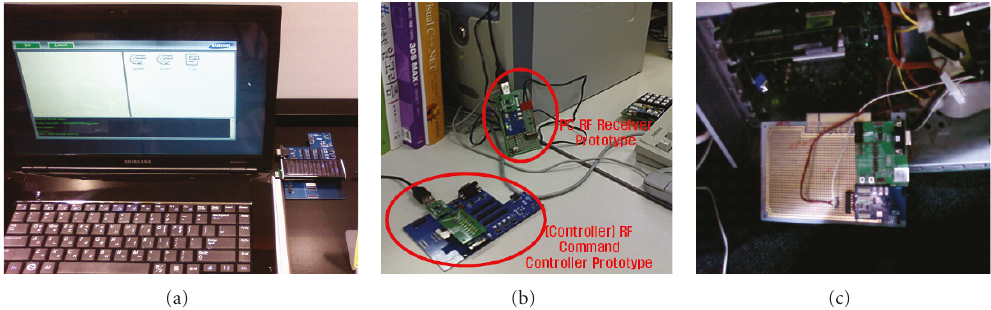
Figure 10: Installed zero-configuration modules for PC extension (USB connection and PCI